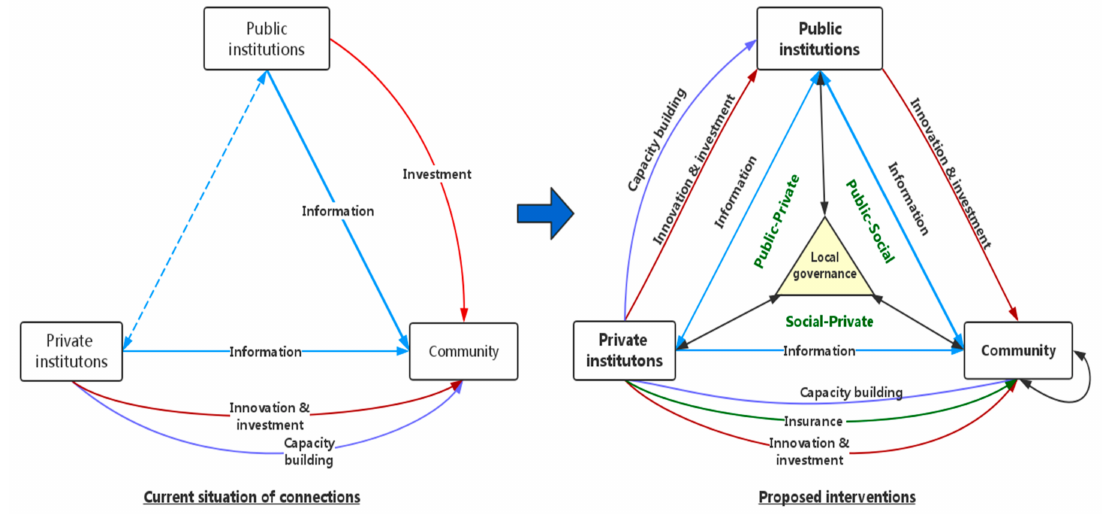
Figure 7. Current and enhanced interactions for local level adaptation to climate